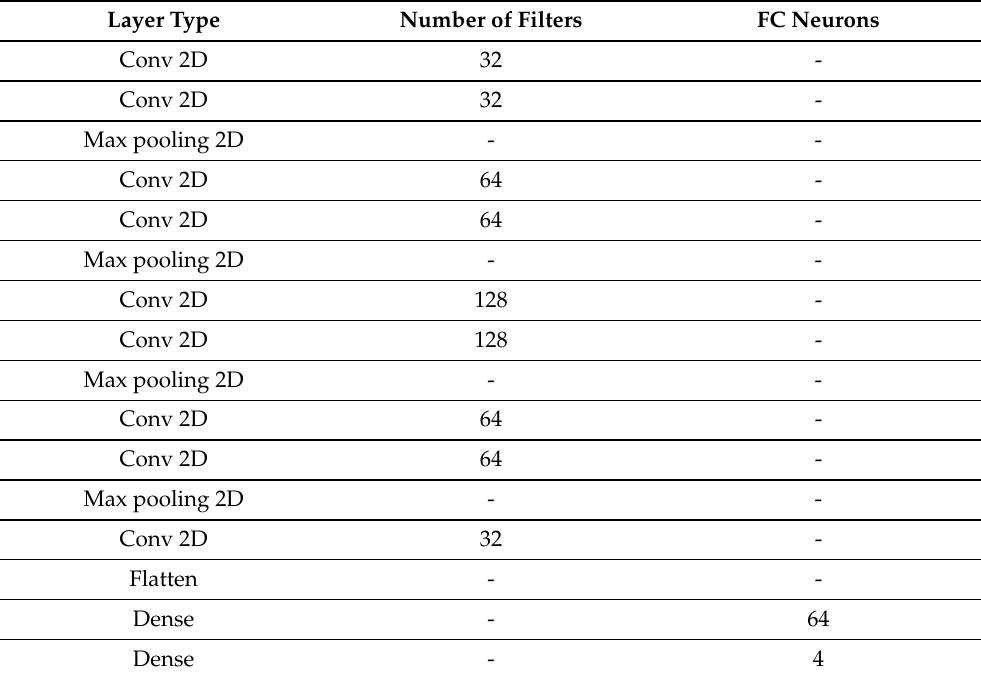
Table 3. The architecture of the neural network used for